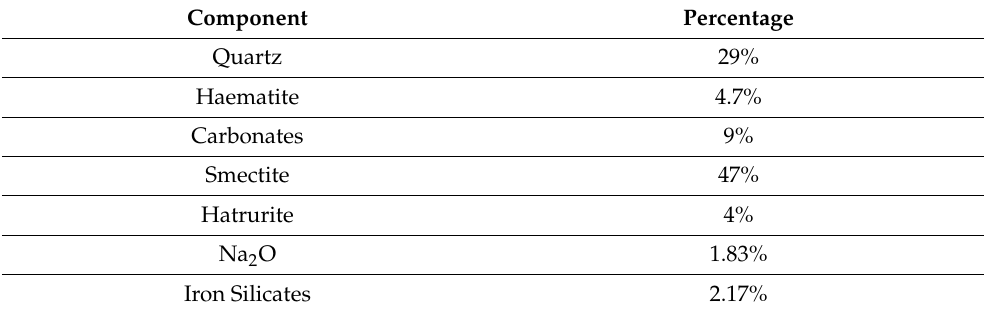
Table 1. Sodium Bentonite composition